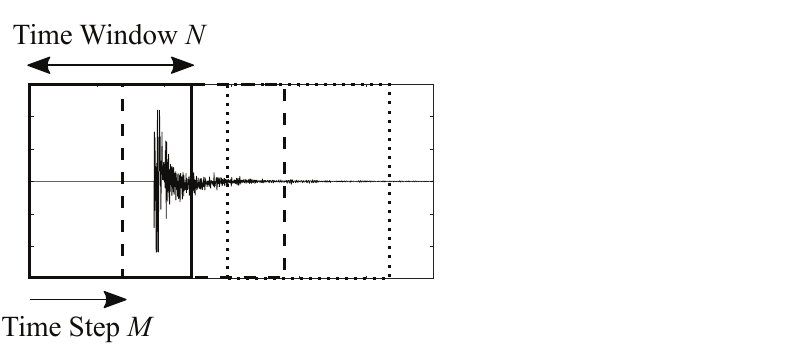
Figure 1. Setting of time windows (solid, dashed, and dotted lines) and time steps for an ob- served